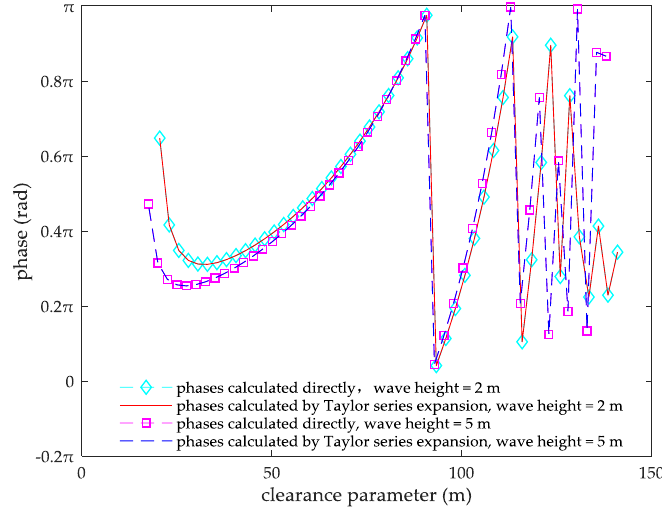
Figure 7. The fitting chart of phases calculated directly and the Taylor series expansion. Sensors 2018 , 18 , x FOR PEER REVIEW